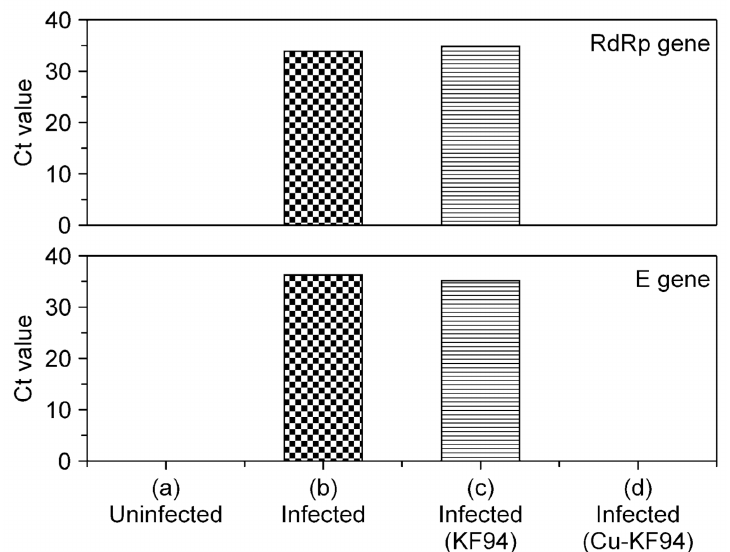
Figure 4. Threshold cycle (Ct) values from real-time polymerase chain reaction demonstrating that the copper-coated KF94 mask inactivated the SARS-CoV-2 virus. Plotted Ct values for RdRp and E genes in Vero cells ( a ) without SARS-CoV-2 virus infection, ( b ) with SARS-CoV-2 virus infection, ( c ) with SARS-CoV-2 virus infection after 1 h contact with uncoated K94 mask, and ( d ) with SARS-CoV-2 virus infection after 1 h of contact with copper-coated K94 mask. The SARS-CoV-2 nucleocapsid immunochemical fluorescence signal was also used to demonstrate the antiviral ability of the copper-coated PP filters (Figure 5). Vero cells were infected with SARS-CoV-2, and immunofluorescent staining of the nucleocapsids was performed, with the nucleocapsid and Hoechst stains being observed as green and blue fluorescent emissions, respectively. The Hoechst stain was used to stain DNA, allowing identification of the cell nuclei. The uncoated KF94 control sample exhibited bright green nucleocapsids, while the nucleocapsid expression of SARS-CoV-2 was reduced by 75% in the copper-coated KF94 samples ( n = 4). These in vitro results confirmed that the copper- coated PP filter had excellent antiviral activity against the SARS-CoV-2 virus. Accordingly, it is expected to be highly effective in the control of COVID-19 infection.